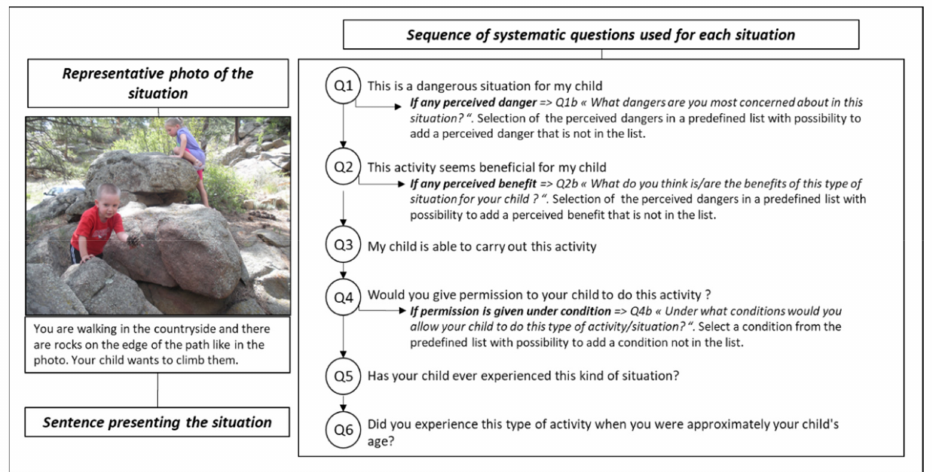
Figure 1. Illustrative representation of the photo-based questionnaire and presentation of the se- quence of systematic questions used for each situation. This is an English translation of the original French